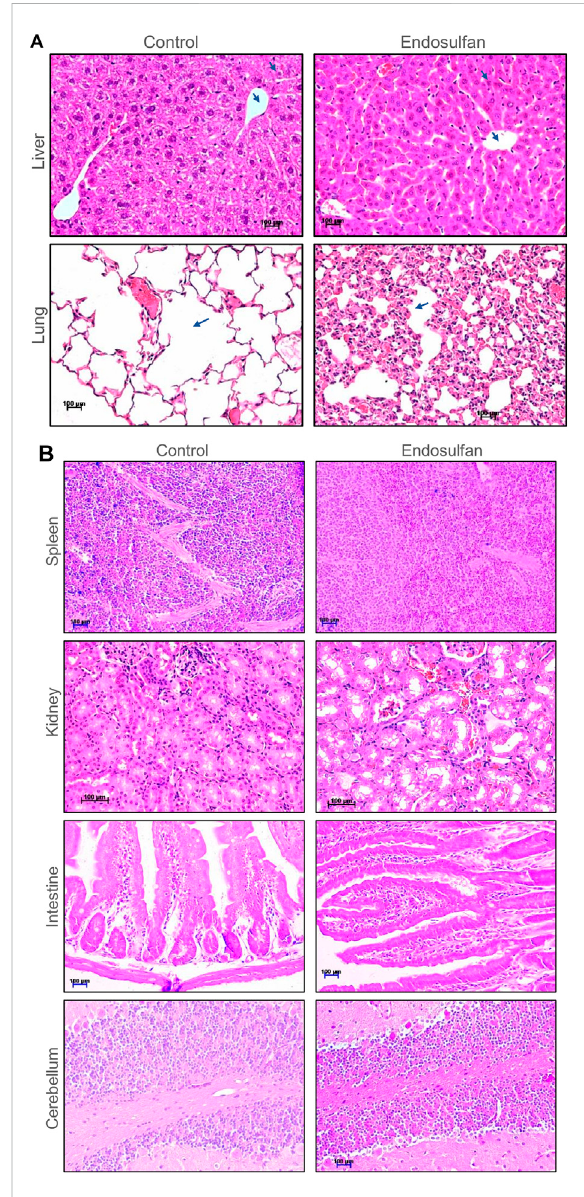
FIGURE 7 Histopathological examination of vital organs of mice post 8 months of ES treatment. (A) Histopathology of liver and lung of mice following ES administration (5 mg/kg, 10 doses). Tissue samples were collected after 8 months of completion of the dose. Control indicates tissue from untreated mice and ES represents tissue from ES treated mice. Hepatocytes and central vein are marked using blue arrows in case of liver. Changes in the architecture of alveoli in lungs is also indicated using arrows. The magni fi cation shown is ×20. (B) Histopathology of spleen, kidney, intestine, and cerebellum of mice following ES administration (5 mg/kg, 10 doses). Control indicates tissue sections from untreated mice and ES represents tissue from ES-treated mice. The experiments were repeated two independent time for each tissue. Magni fi cation shown is of ×20. Scale bar: 100